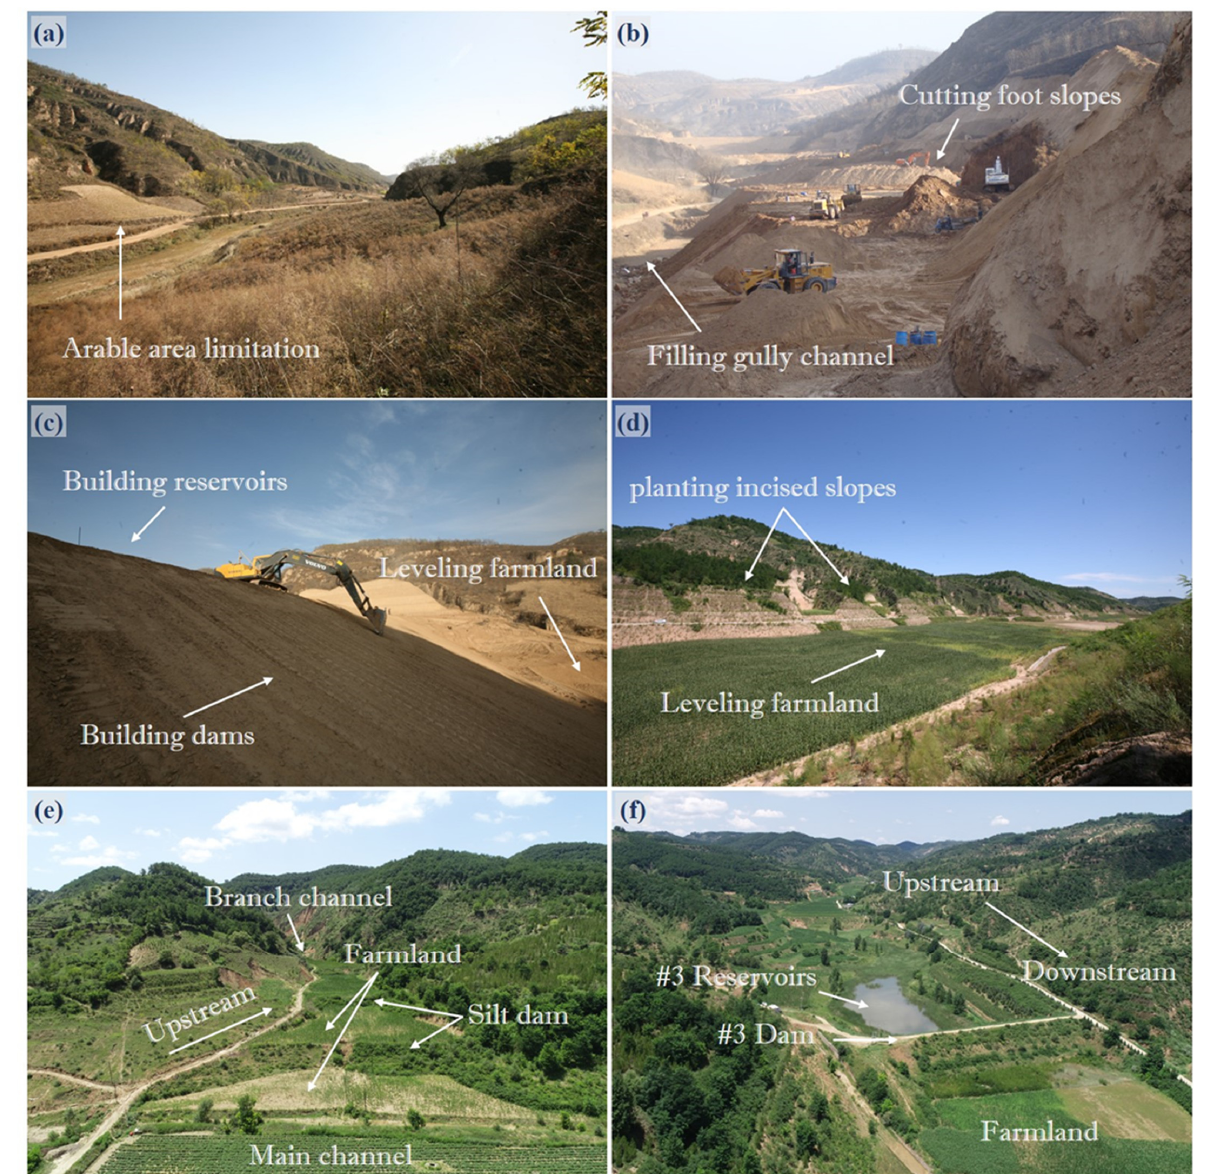
Figure 1. Site photos showing the process and local situation of the GLCP implemented in the Gutun watershed (GTW). ( a ) Original landform; ( b ) cutting foot slopes and filling gully channel; ( c ) building dams and reservoirs; ( d ) leveling farmland and planting cut slopes; ( e ) landscape of branch channel; ( f ) upstream landscape of #3 reservoirs and dam.